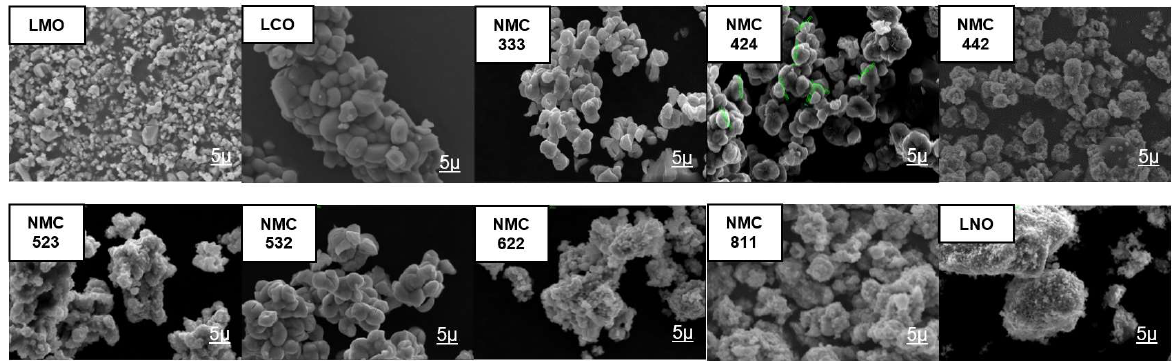
Figure 7. Scanning Electron Microscope images x5000 magnification of LMO, LCO, LNO, and NMC at various compositions.